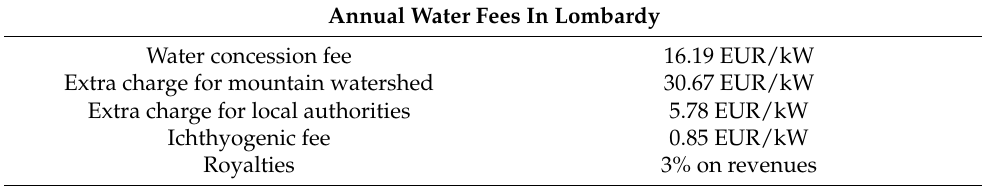
Table 1. Annual water fees for Lombardy [23].